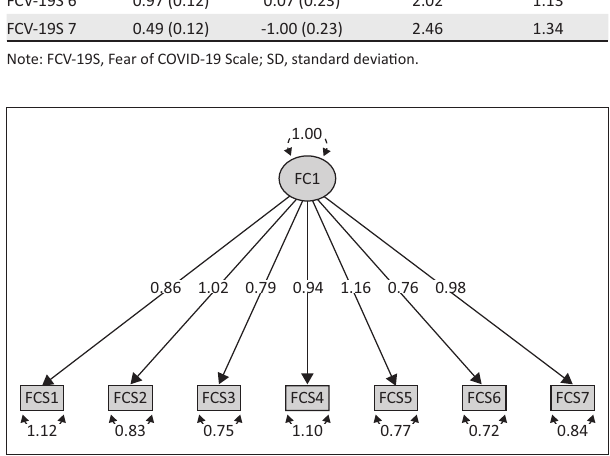
FIGURE 1: Fear of COVID-19 unidimensional